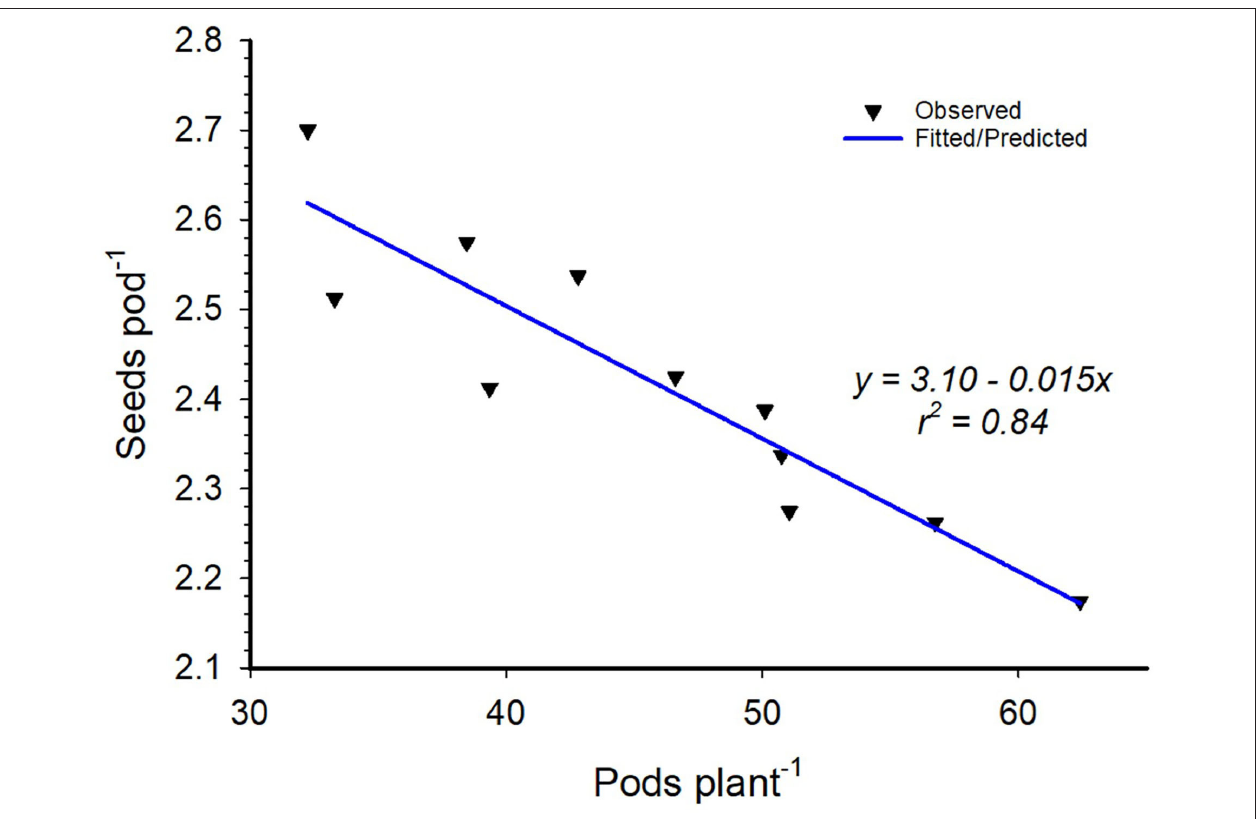
FIGURE 4 | Variety by inoculant interactions of pods per plant and seeds per pod at Ruace in the 2017 growing